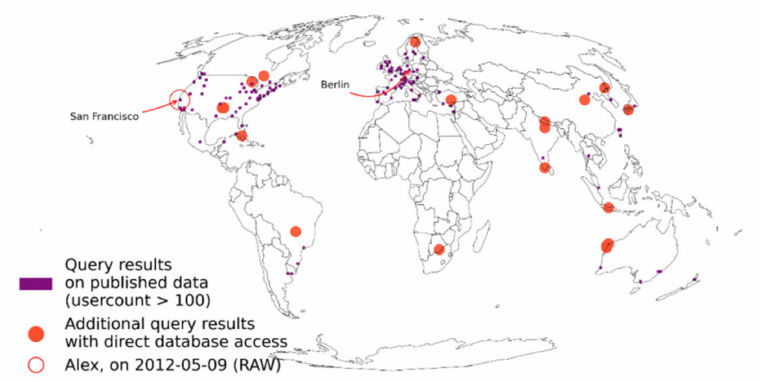
Figure 8. Alex case study, evaluation of scenario “Sandy”.